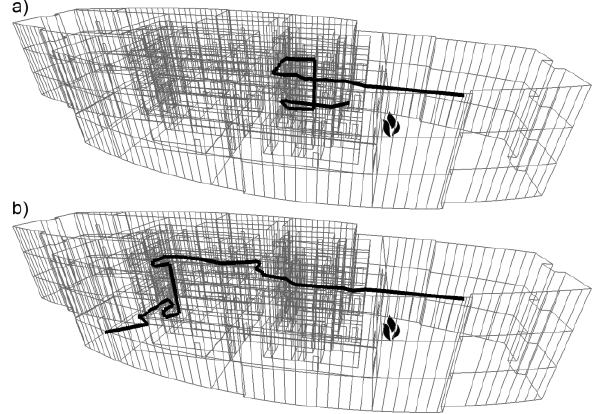
Figure 6. Paths from the selected room (3 rd floor) to an exit from the building: a) the shortest path; b) the safest